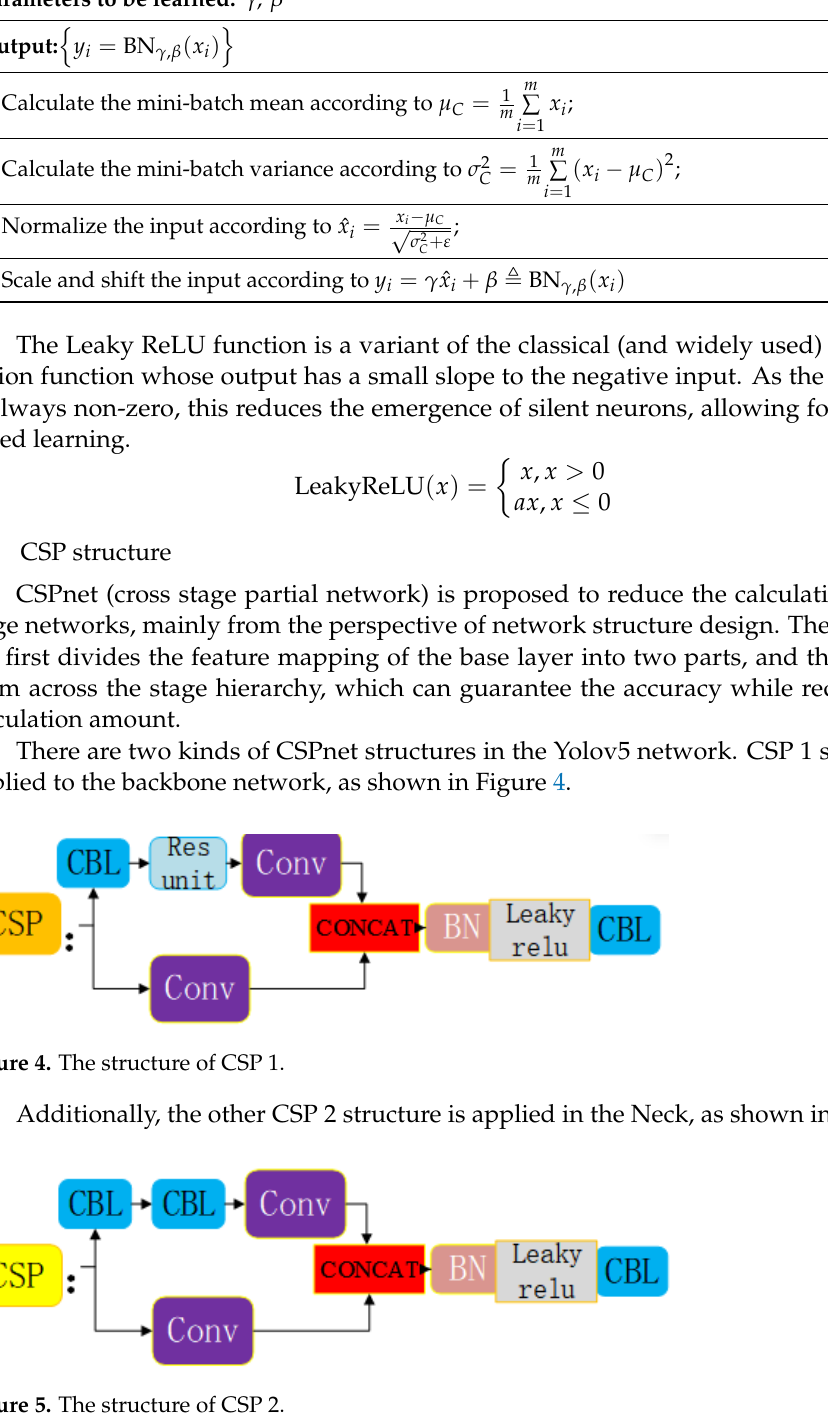
： Upsampling FPN structure PAN structure ： Downsampling Figure 6. The structure of FPN and PAN. 3.1.4. Prediction In Yolov5, CIOUs_Loss is used to create the loss function of the bounding box. In the post-processing procedure during target detection, screening for many target boxes usu- ally requires NMS operation. The weighted NMS in Yolov5 can improve the recognition of the target to be detected. In the official description, there are four versions of the target detection networks, namely Yolov5s, Yolov5m, Yolov5l, and Yolov5x, as shown in Table 2. Table 2. The parameters of different Yolov5 networks. Yolov5s